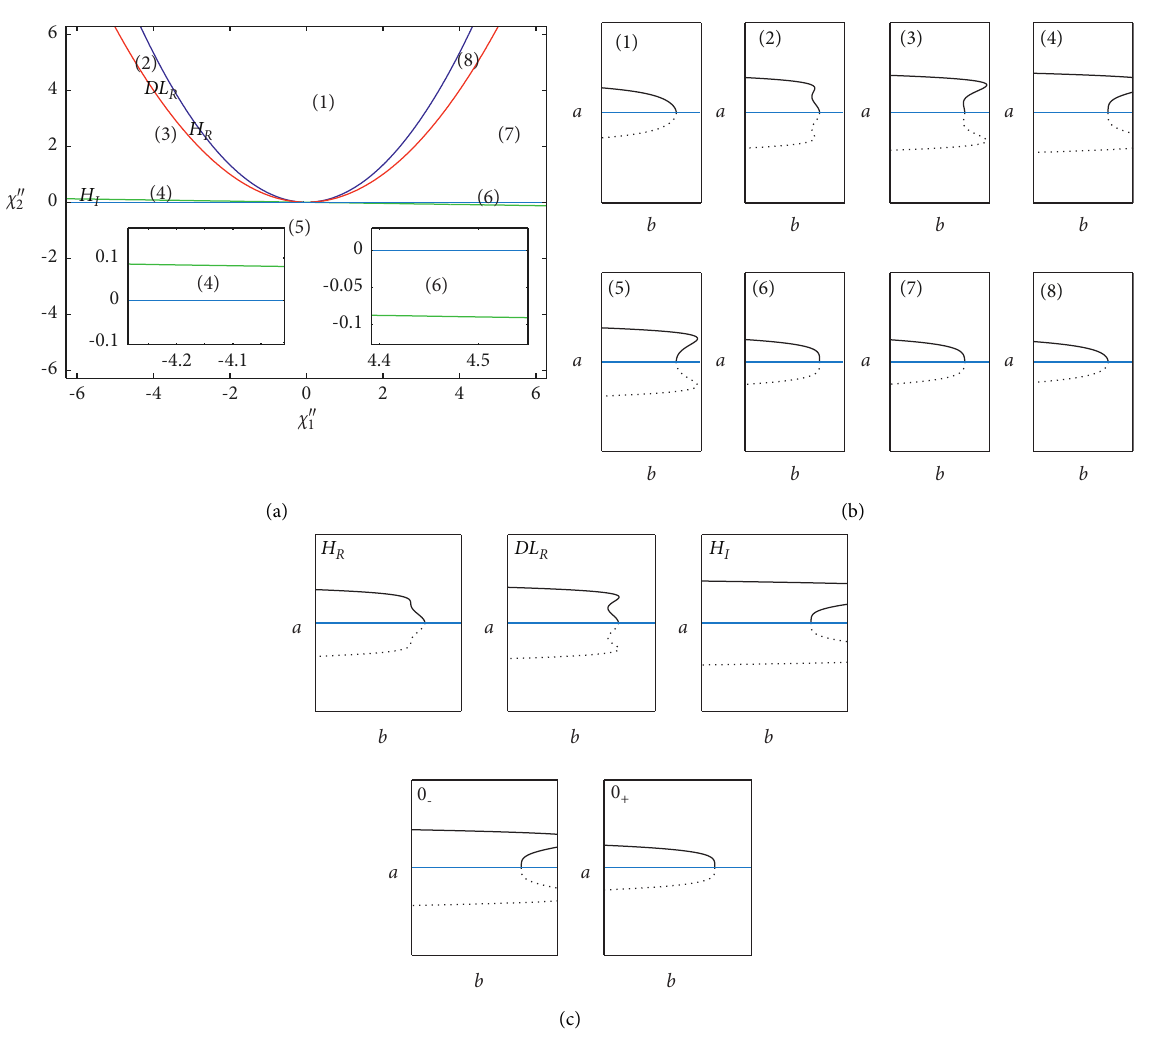
Figure 9: (a) Transition set and (b, c) bifurcation diagrams of the